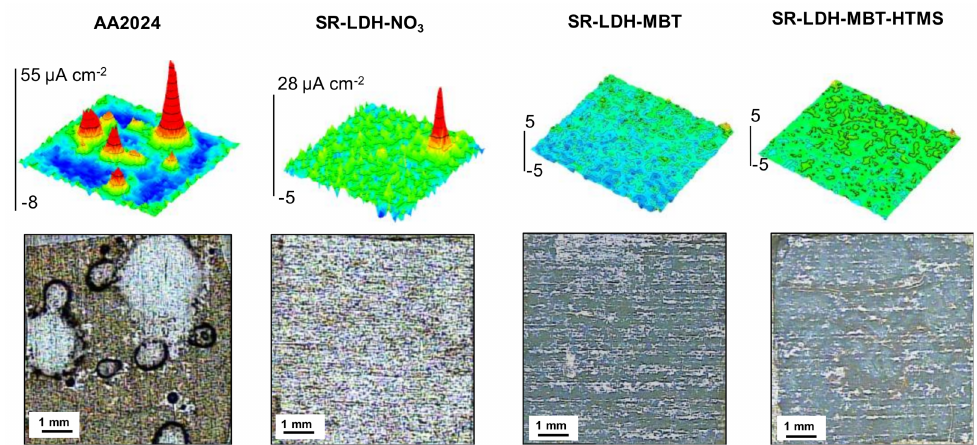
Figure 4. Scanning vibrating electrode technique (SVET) maps and photographs of samples surfaces after 7 days of immersion in 0.05 M NaCl of the bare alloy (AA2024), and the alloy with SR-LDH-NO 3 , SR-LDH-MBT and SR-LDH-MBT-HTMS.